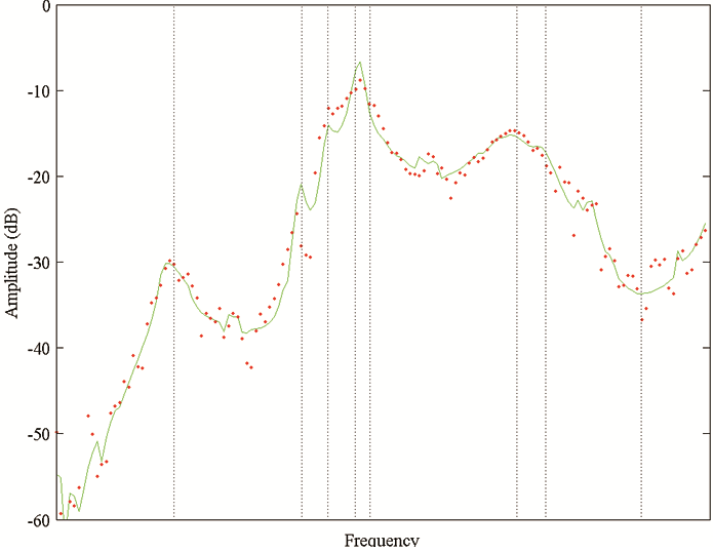
Fig. 10. Typical FRF: non-parametric estimate (red dots), OMAX FRF fit (green line); the manufacturer’s identified resonant frequencies are the vertical dotted lines. The XP  are calculated from the unexcited part using the Welch periodogram method with 11 blocks and 50% overlap, weighted with a Hanning window. Exactly the double of the number of data points is used compared with the FRF, to account for the reduction in points when calculating the positive power spectra. The XP + is also curve-fitted using a MLE with model order 32. The transmissibility functions were obtained by comparing loading condition one (exciter on), where 7 blocks could be used, and loading condition two (turbulence only) with 11